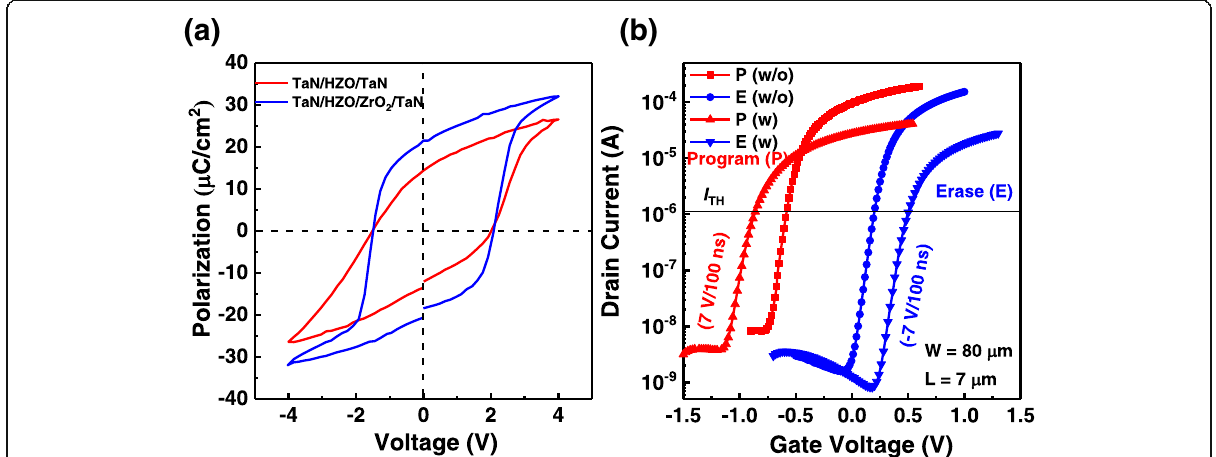
Fig. 2 a P – V hysteresis loops of TaN/HZO/TaN and TaN/HZO/ZrO 2 /TaN MFM structures measured at 4 V and a frequency of 5 kHz. b I D – V G curves of HZO-based FeFETs with (w) and without (w/o) ZrO 2 seed layers after a program pulse (+ 7 V/100 ns) and an erase pulse ( − 7 V/100 ns)